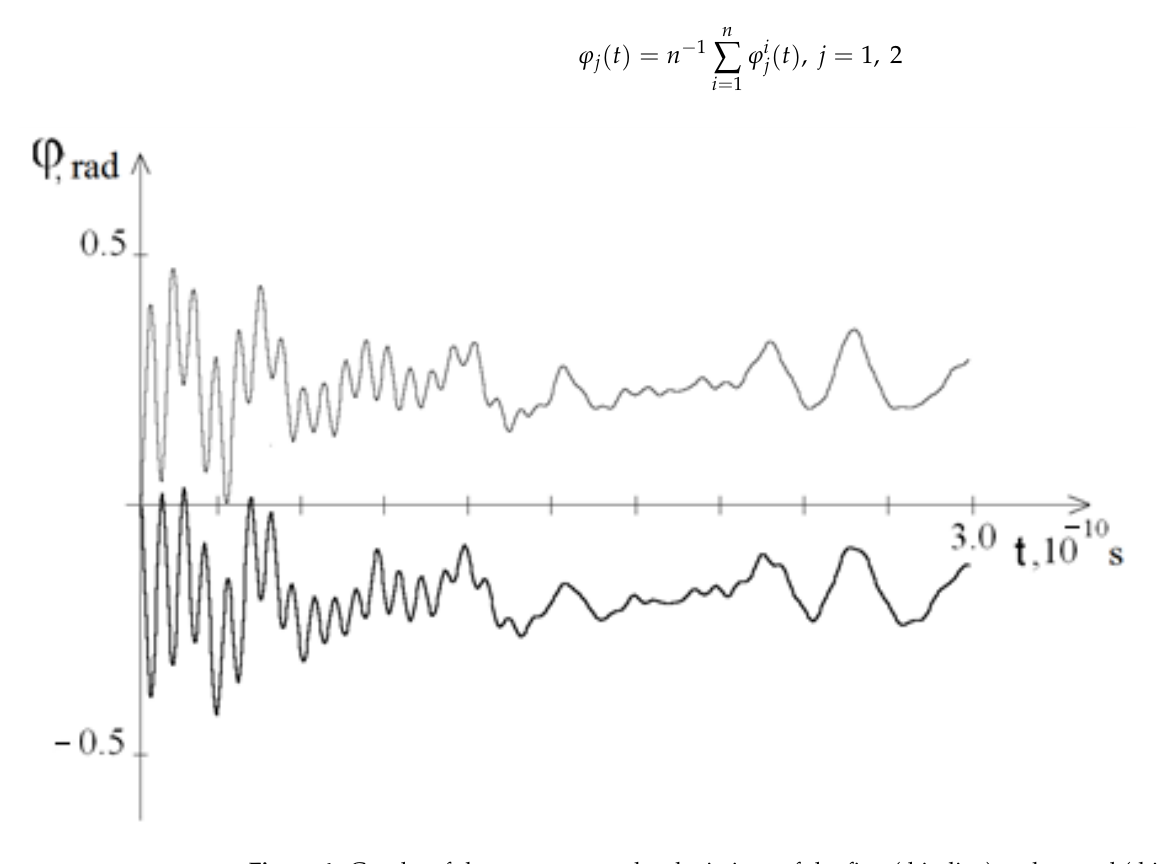
Figure 4. Graphs of the average angular deviations of the first (thin line) and second (thick line) strands of DNA nitrogenous bases at M 0 = 13.172 over the time interval [0, 3 T 0 ].